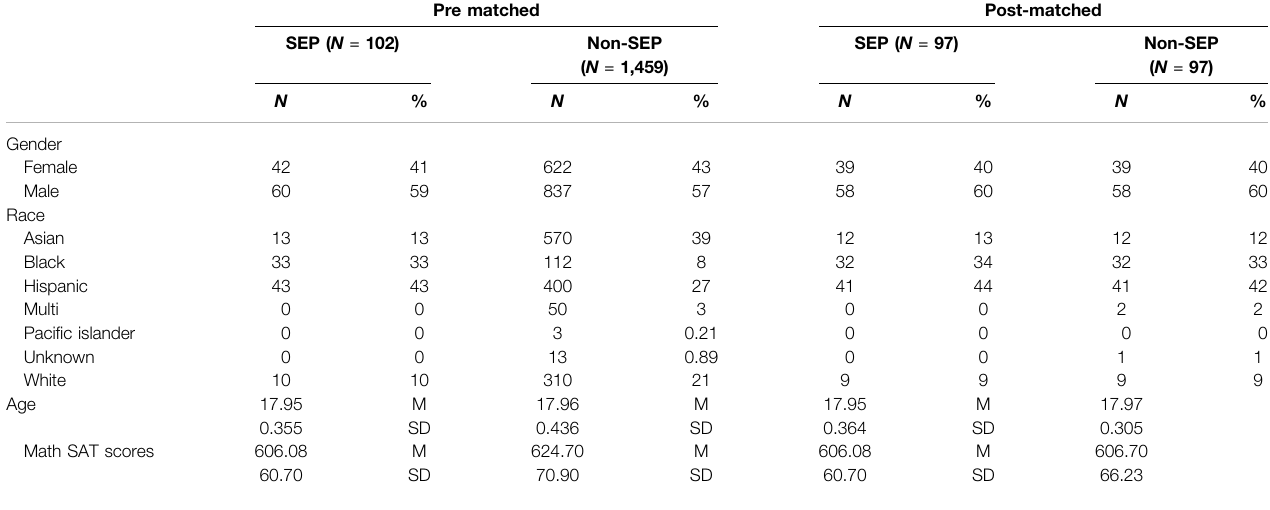
TABLE 2 | Descriptive Statistics- Full Sample of SEP Bridge and Non-SEP Bridge Students. By Dina Ghazzawi, Donna Pattison, and Catherine